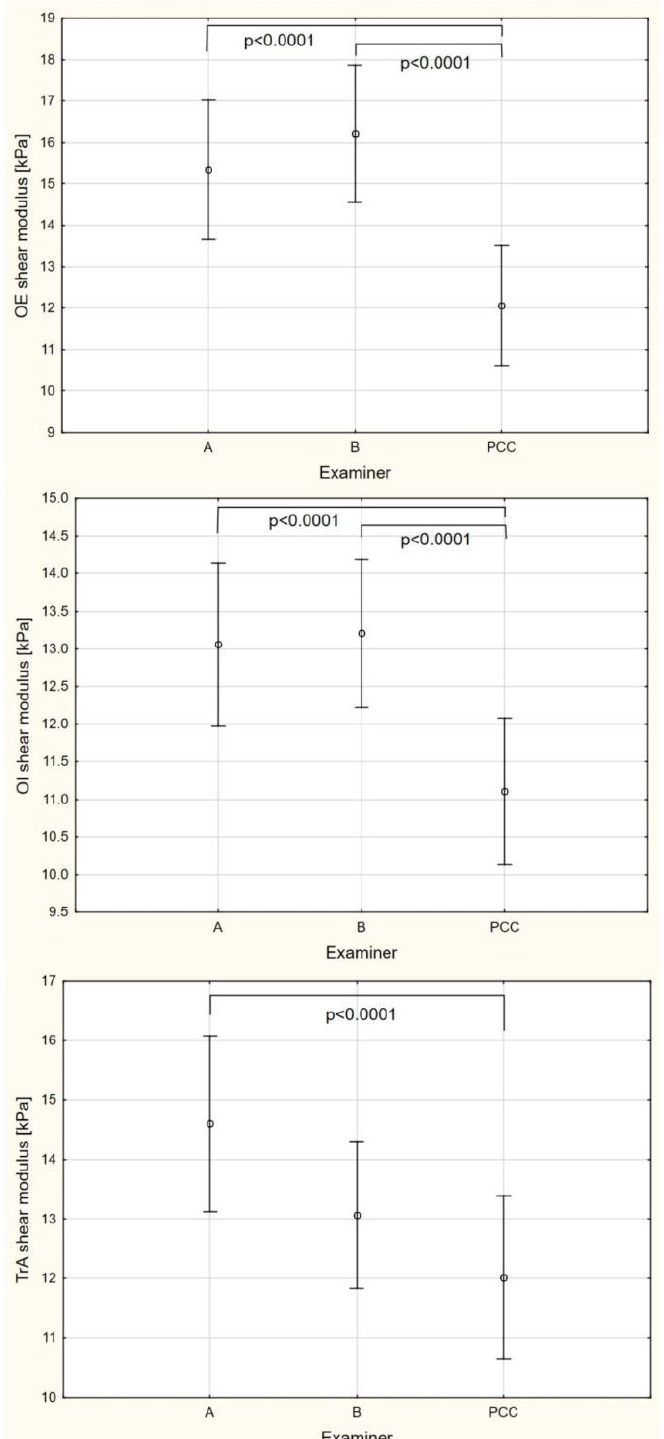
Figure 5. Absolute muscle elasticity performed by examiner A, B, and with probe compression con- trolled (PCC). OE: Oblique external; OI: Oblique internal; TrA: Transversus abdominis. controlled (PCC). OE: Oblique external; OI: Oblique internal; TrA: Transversus